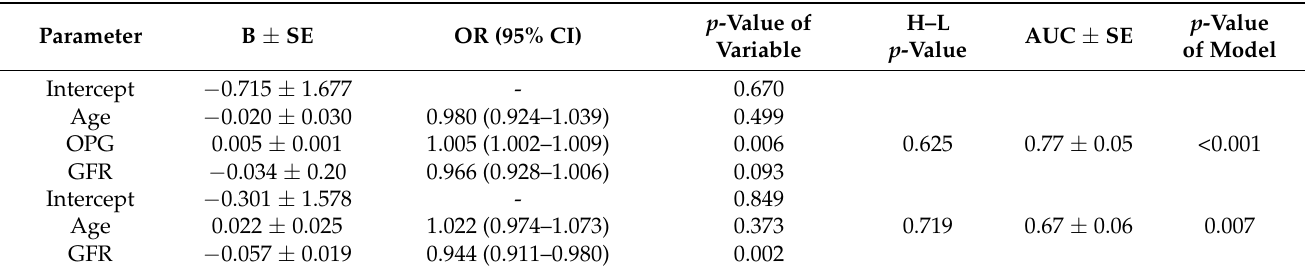
Table 6. Markers associated with poor prognostic factors in chronic kidney disease patients based on a logistic regres- sion model.